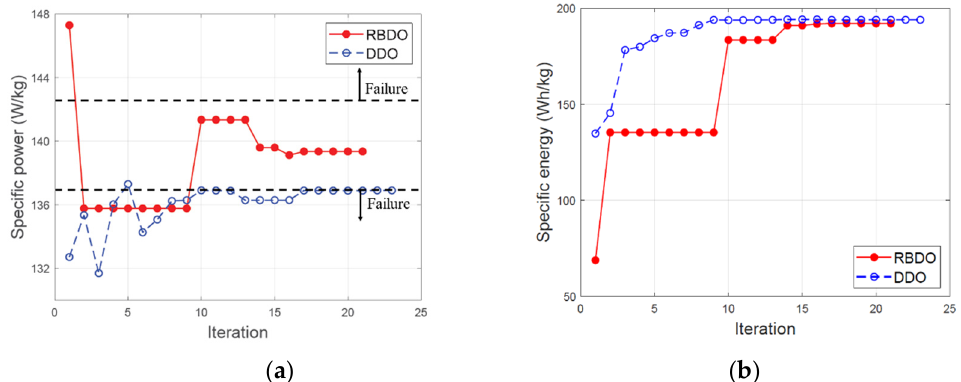
Figure 11. Convergence histories of the reliability-based design optimization (RBDO) and determin- istic design optimization (DDO) ( a ) specific power; ( b ) specific energy.